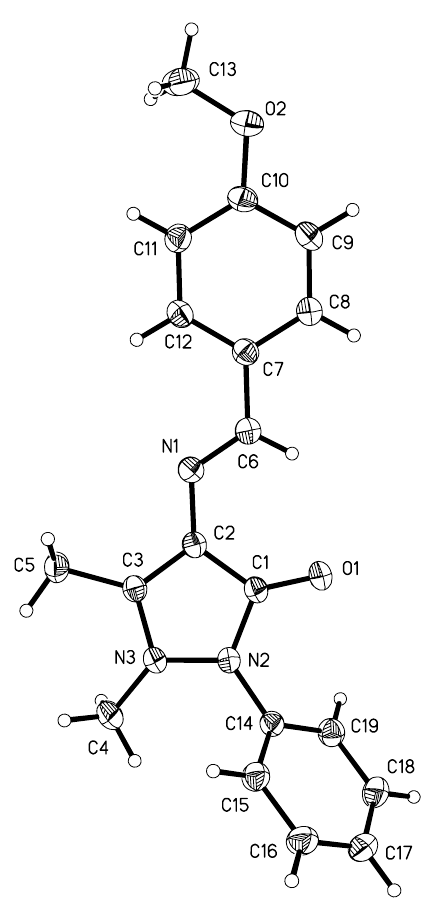
ring is 46.8(5)°. The N3N2C14C19 and C1N1C14C15 torsion angles are 155.7(2)° and 118.9(3)°, respectively. The O1 atom deviates from the pyrazoline mean plane by 0.109(3) Å,